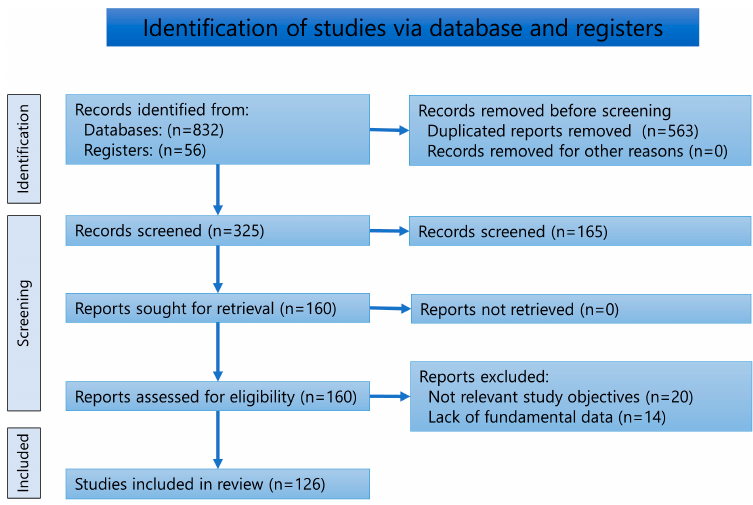
Figure 1. PRISMA diagram of the literature search and screening.